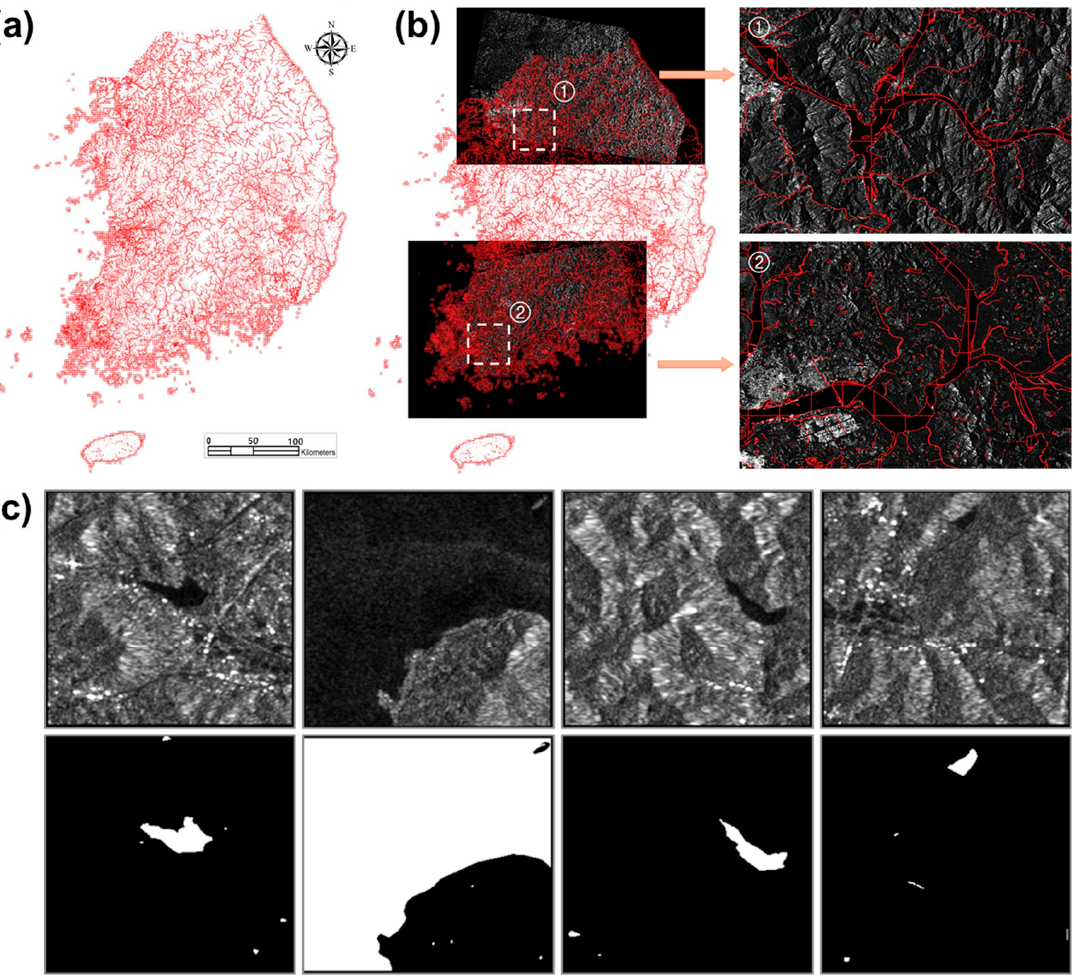
Figure 3. Producing training data for the research: ( a ) mosaicked land cover maps for 2018; ( b ) land cover maps overlaid on Sentinel-1 images for matching and cropping layers, and enlarged images ① and ② for visual verification; ( c ) examples of paired satellite image patches (top) and label data (bottom) produced for training and inference.